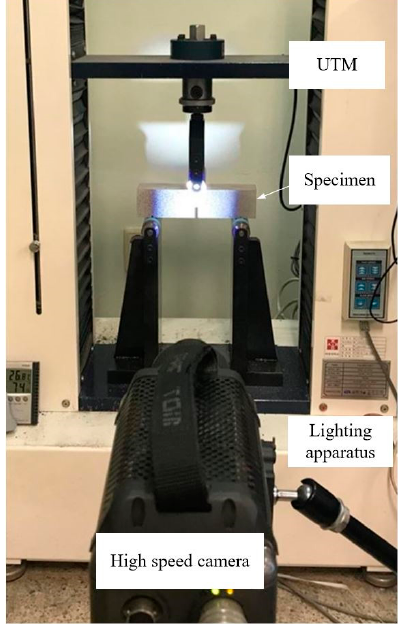
Figure 5. Test setup for the IFT test. [4].